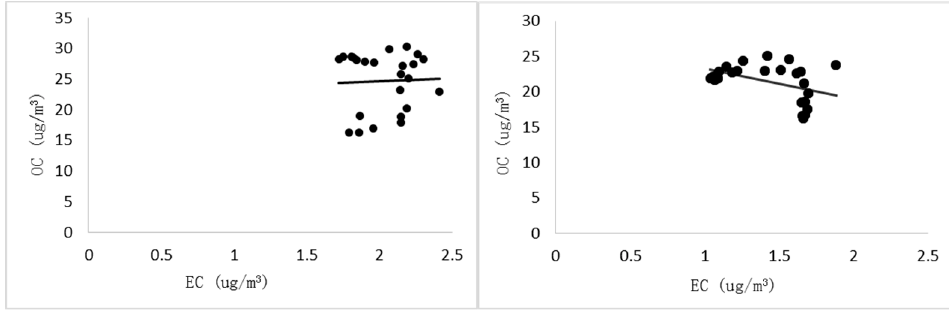
Figure 5. Correlation between OC and EC during heating and non-heating periods.